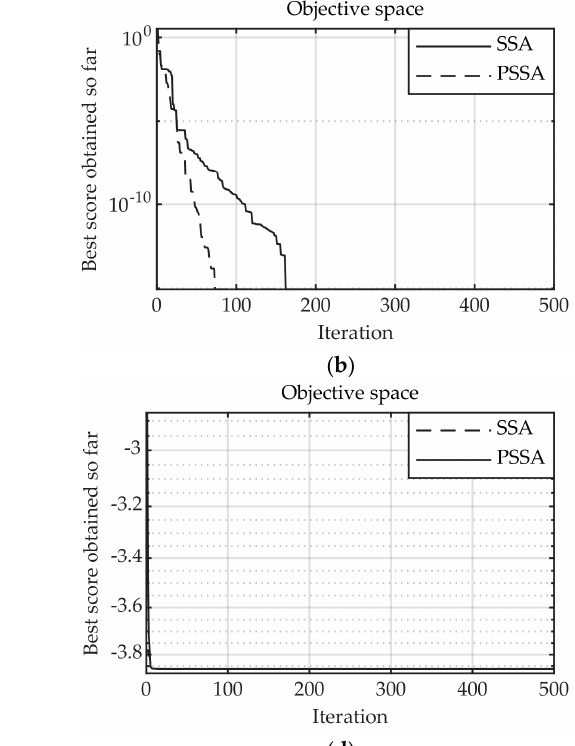
Figure 9. Convergence comparison between SSA and PSSA: ( a ) 𝑓 (cid:2871) ; ( b ) 𝑓 (cid:2869)(cid:2868) ; ( c ) 𝑓 (cid:2869)(cid:2876) ; ( d ) 𝑓 (cid:2869)(cid:2877) .